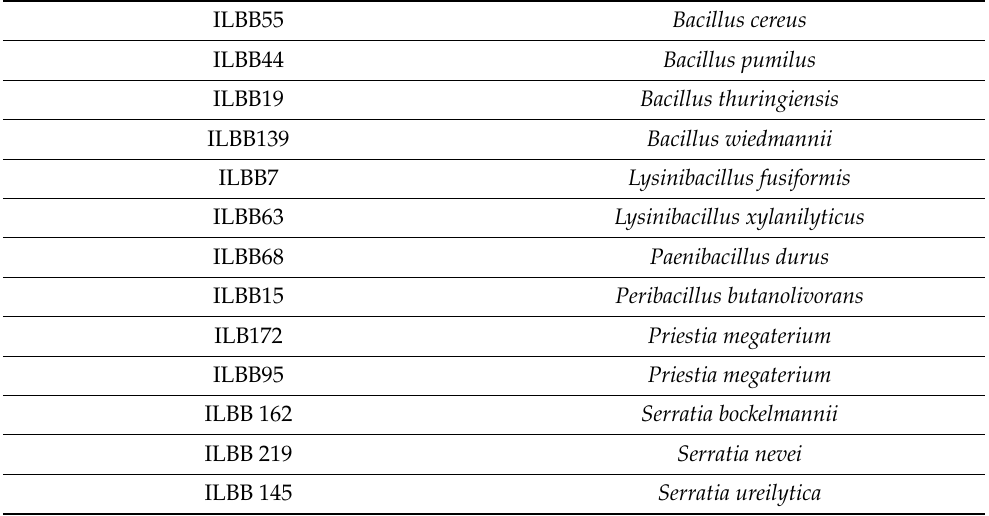
Table 1. Bacterial strains screened for production of antimicrobial and antibiofilm extracts.